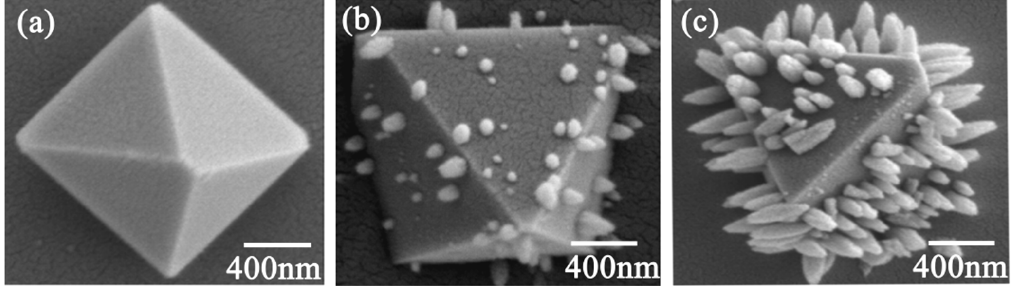
Figure 4. SEM images of samples nucleated at 680 °C for ( a ) 2 h, ( b ) 4 h, and ( c ) 12 h.